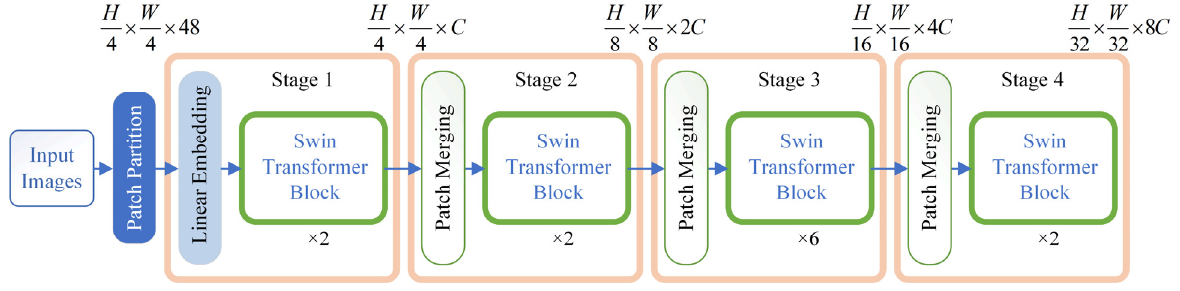
Figure 3. The architecture of the Swin Transformer.